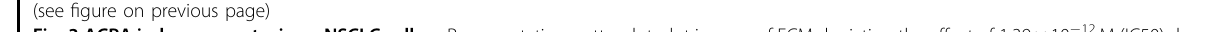
Fig. 3 ACPA induces apoptosis on NSCLC cells. a Representative scatter dot-plot images of FCM depicting the effect of 1.39 × 10 − 12 M (IC50) dose of ACPA on NSCLC cells labeled with Annexin/PI. The percentage of viable, early, and late apoptotic to total ACPA-treated A549, H1299, H358, and H838 cells are shown with comparison to control at 24, 36, 48, and 72 hours. b , c Error bar graphs demonstrating early ( b ) and late ( c ) apoptotic indices for A549, H1299, H358, and H838 cells at 24, 36, 48, and 72 hours. a , b , c , and d demonstrate p < 0.05 comparing to 24, 36, 48, and 72 hours respectively, one-way analysis of variance (ANOVA). d Correlation graph between cell viability by RTCA and apoptosis by FCM following ACPA treatment of A549 ( p = 0.01), H1299 ( p = 0.667), H838 ( p = 0.01), and H358 ( p = 0.01) cells, Spearman ’ s test. e – p Left and right columns present the transmission electron micrographs of control and ACPA-treated groups respectively. All cancer cells exhibit cytoplasmic organelle composition of undifferentiated state with the lack of tubular systems. Note the presence of pleomorphic mitochondria with degenerated cristae and autophagic vacuoles in ACPA-treated groups ( g , h , k , l , o , p ). N: nucleus, n: nucleolus, (*): degenerated mitochondria, white arrow: autophagic vacuole. e , g , i , k , m , o , scale bar, 0.5 µm, f , h , j , l , n , p , scale bar, 200